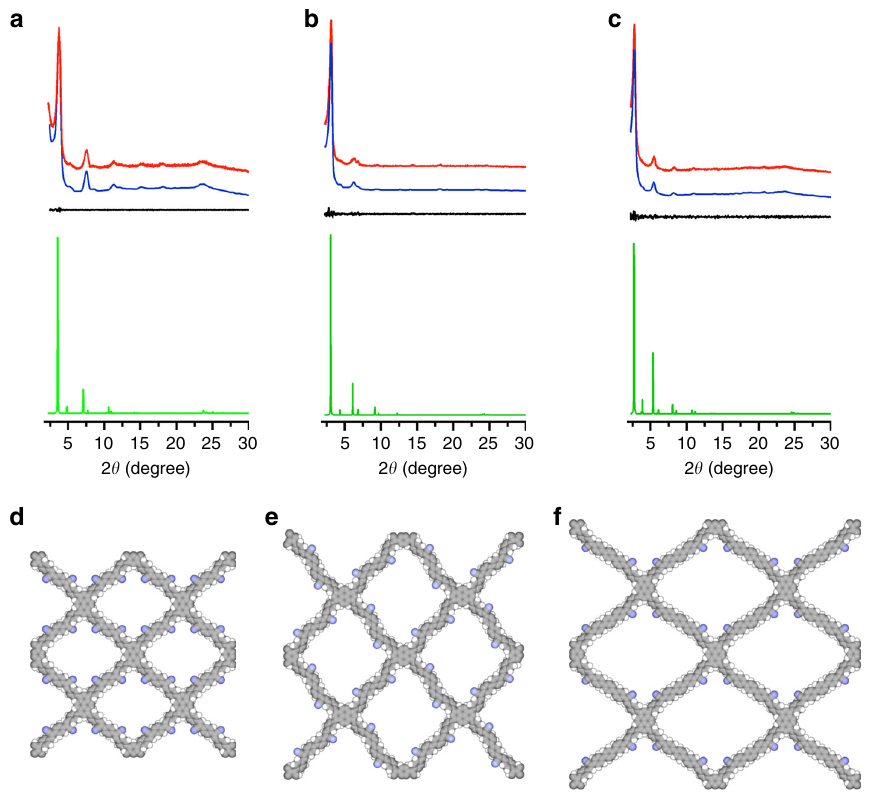
Fig. 4 Crystal structure. a – c PXRD pro fi les of a sp 2 c-COF, b sp 2 c-COF-2, and c sp 2 c-COF-3. Experimentally observed (red curve), Pawley re fi ned (blue curve), their difference (black curve), and simulated AA stacking mode (green curve). d – f Lattice structure of d sp 2 c-COF, e sp 2 c-COF-2, and f sp 2